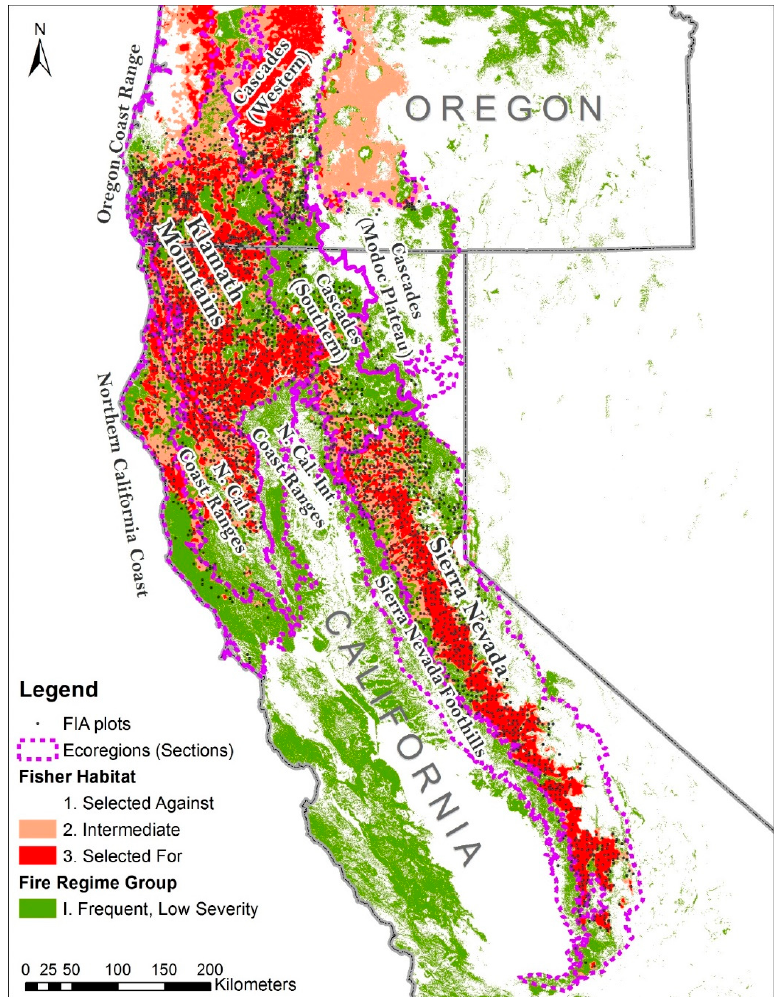
Figure 3. Map of the study area in California and Oregon, USA, showing ecoregions, areas of frequent, low severity fire regime, habitat for fishers, and the approximate location of the Forest Inventory and Analysis (FIA) plots that have at least one tree from the eight study species.